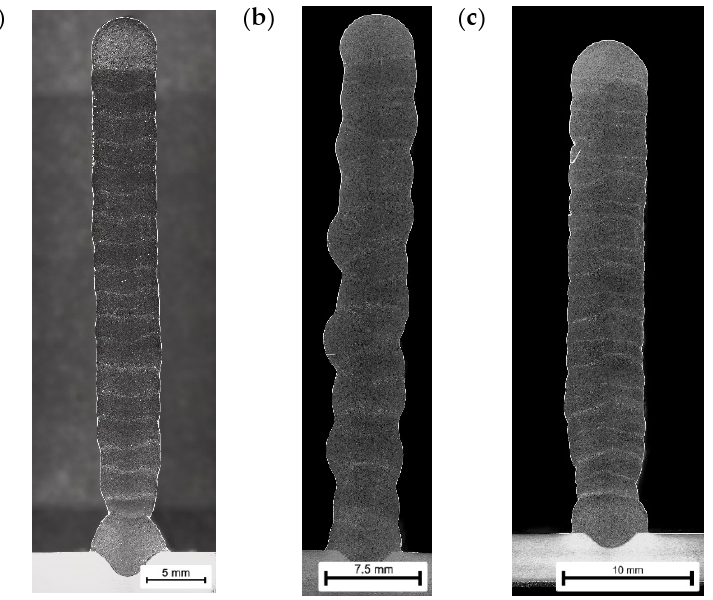
Figure 8. Necking-effect correction in ( a ) Ar + hatching with 18 L/min gas flow without sequential reduction of welding parameters, ( b ) Ar + hatching with 18 L/min and sequential reduction, and ( c ) Ar + cirlcing with 30 L/min gas flow.